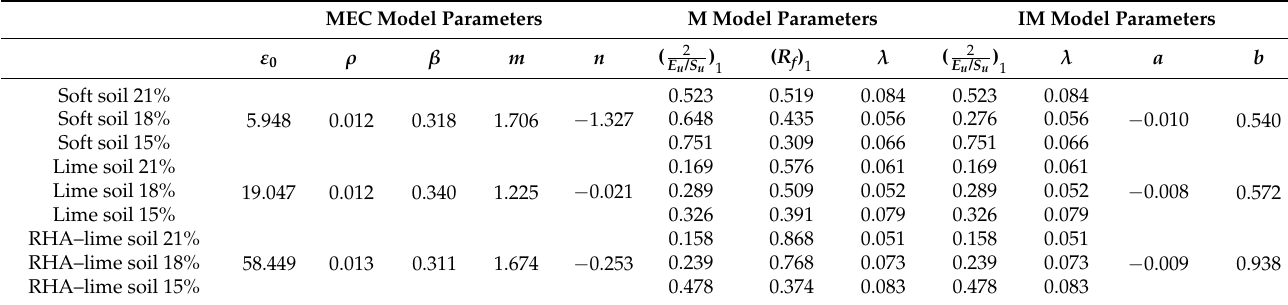
Table 5. Values of the parameters of different creep models.